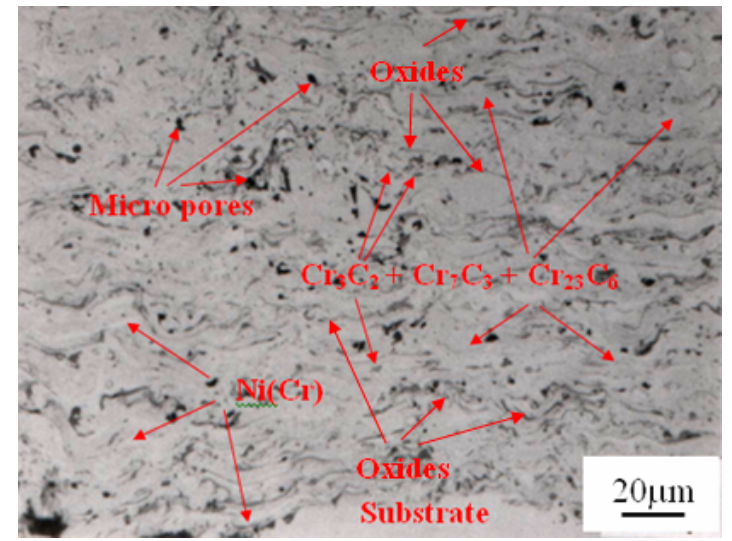
Figure 8 – 75Cr3C2 - 25Ni(Cr) coating microstructure deposited with the powder feed rate of 45 g/min Slika 8 – Mikrostruktura 75Cr3C2 - 25Ni(Cr) prevlake deponovane sa brzinom dovoda praha 45